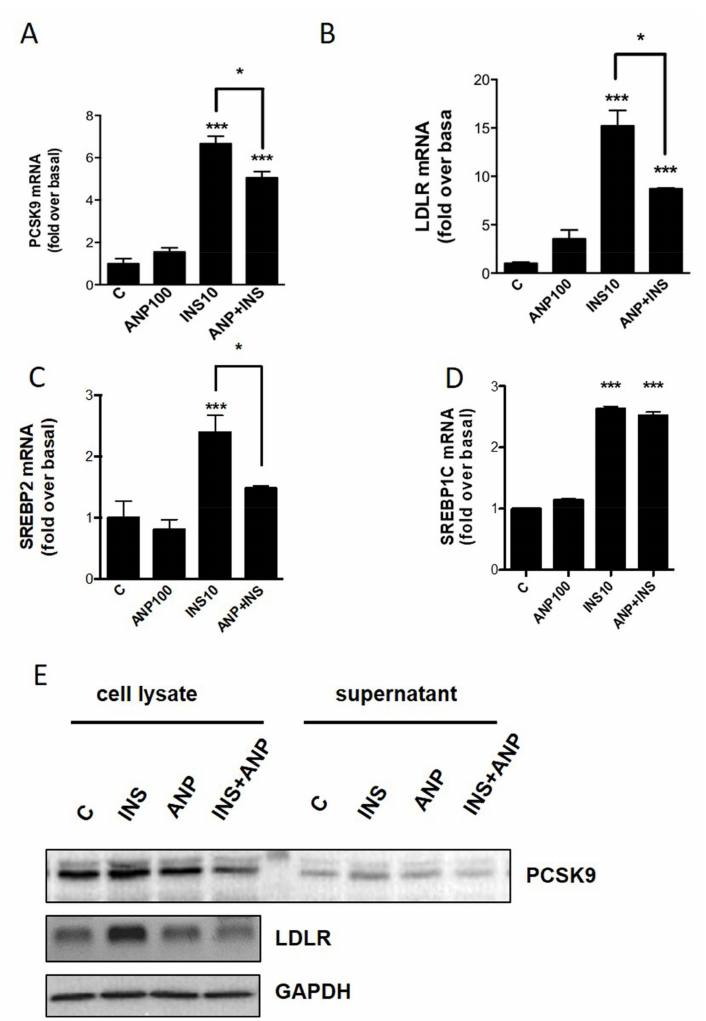
Figure 3. One-way ANOVA. ( A ) Effects of insulin and ANP on PCSK9 in differentiated human adipocytes. ( B ) Effects of insulin and ANP on LDLR in differentiated human adipocytes. ( C ) Effects of insulin and ANP on SREBP-2 in differentiated human adipocytes. ( D ) Effects of insulin and ANP on SREBP-1c in differentiated human adipocytes. ( E ) PCSK9, LDLR, and GAPDH levels after treatment with insulin and ANP. *** p < 0.001 vs control; * p < 0.05 insulin 10nM vs insulin+ANP